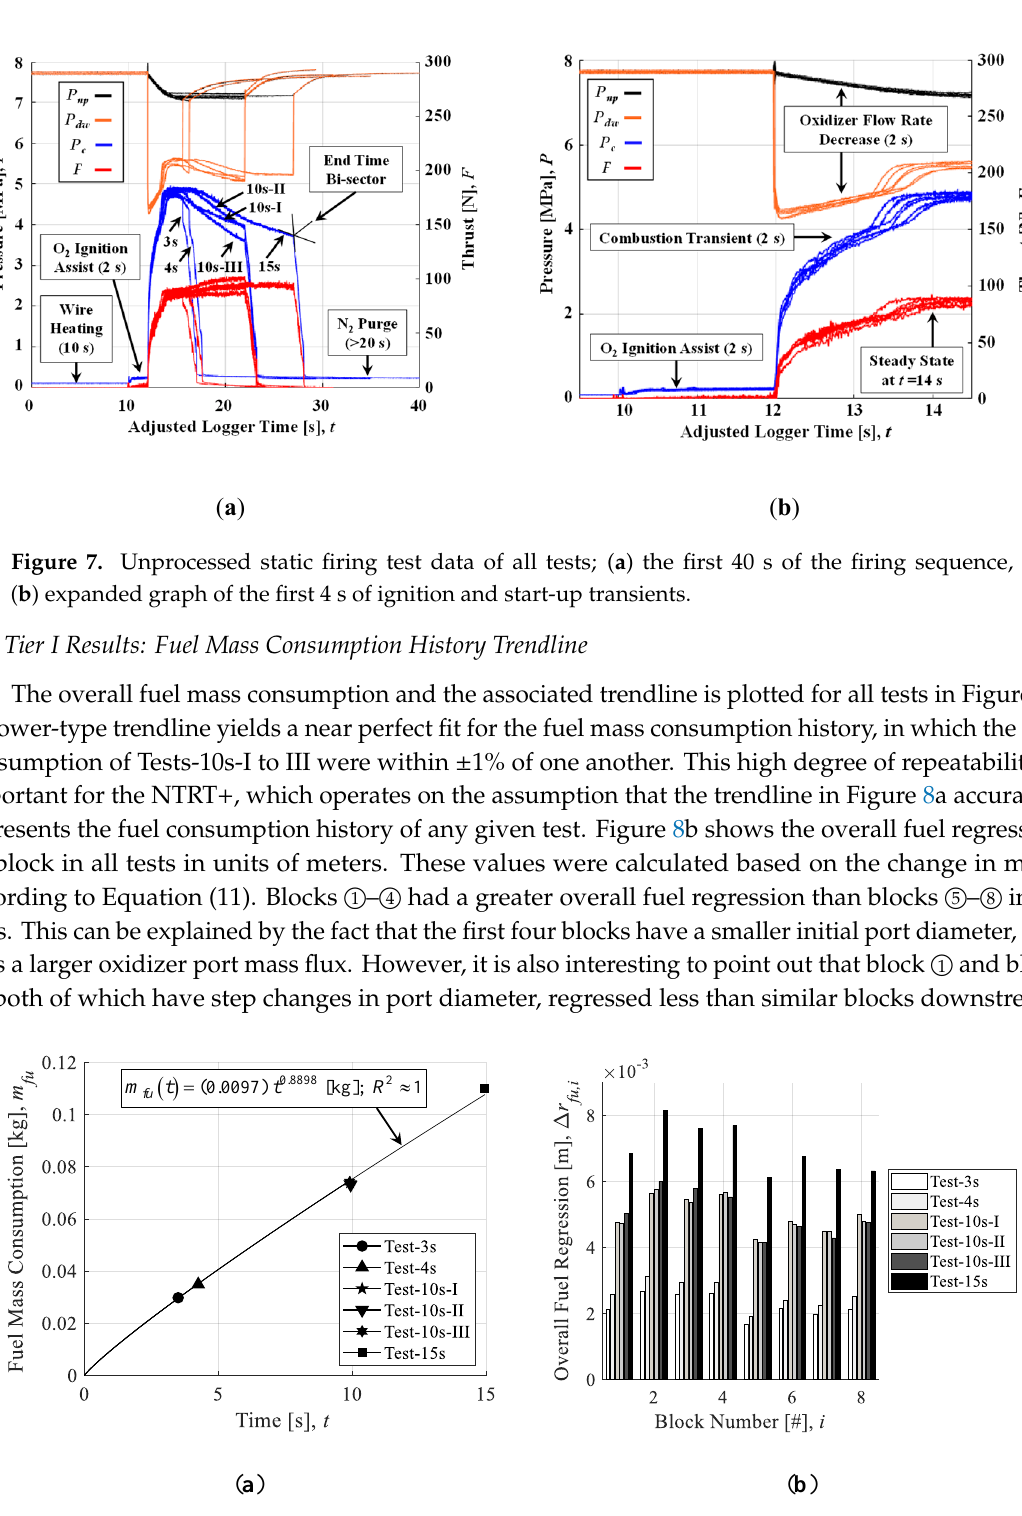
Figure 8. Fuel consumption analysis ( a ) fuel mass consumption trendline; ( b ) fuel regression by block. 410